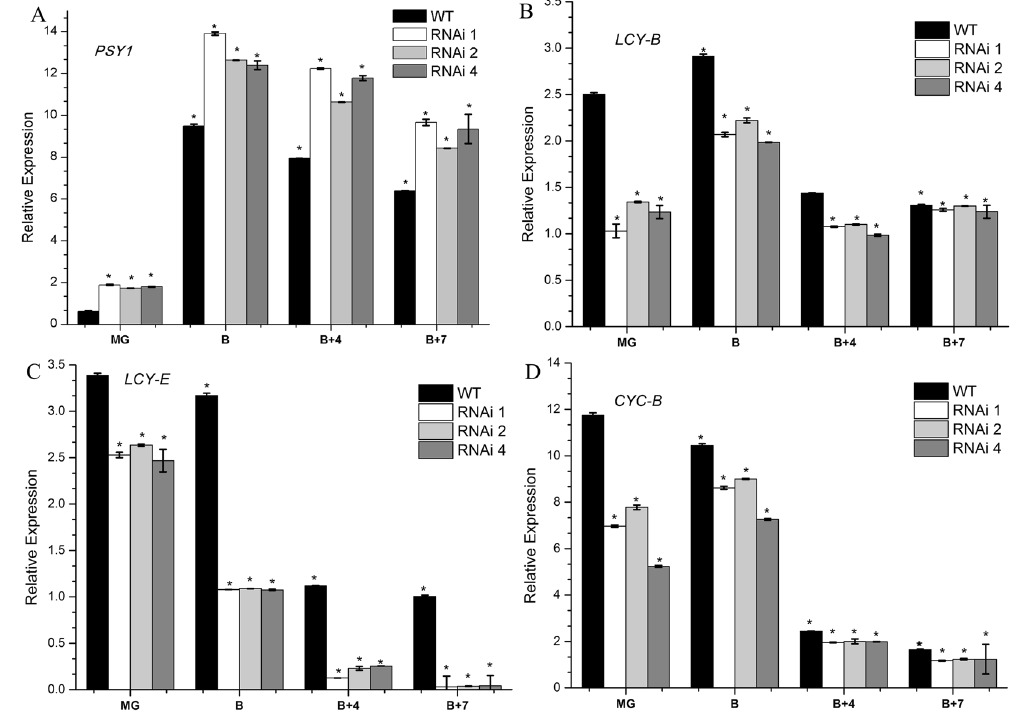
Figure 3. Expression of carotenoid biosynthesis genes PSY1 , LCY-B , LCY-E and CYC-B in pericarp between wild type (WT) and SlHDA1 RNAi lines. MG, mature green; B, breaker; B + 4, 4 d after breaker stage; B + 7, 7 d after beaker stage. Three biological replications and three technical replications for each sample were performed. Data are the means ± SD of three independent experiments. The asterisks indicate statistically significant differences between the WT and transgenic fruits (P <